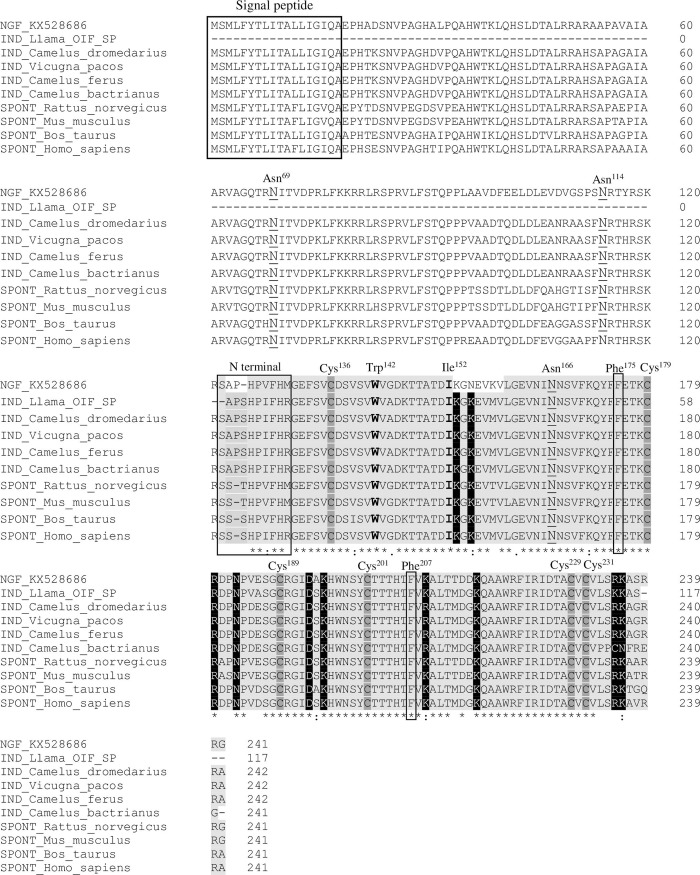
Amino acid sequence alignment of β-NGF in induced- and spontaneous ovulating species.IND (induced-ovulating species). NGF_KX528686: Oryctolagus cuniculus, KX528686; Llama_OIF_SP: ovulation inducing factor from SP of Lama lama, 4EFV_B; Camelus dromedarius, XP_010979007.1; Vicugna pacos, XP_015102944.1; Camelus bactrianus, XP_010967135.1. SPONT (spontaneous-ovulating species). Rattus norvegicus, NP_001263984.1; Mus musculus, NP_001106168.1; Bos Taurus, NP_001092832.1; Homo sapiens, NP_002497.2. The signal peptide is indicated in a box. Underlying residues (N69, N114 and N166) show glycosylation sites of Pro-NGF. The beta chain of β-NGF appears in light grey. Cysteines involved in disulfide bonds are indicated in dark gray (Cys136, Cys179, Cys189, Cys201, Cys229, Cys231). Amino acids that participate in both TrkA and p75 binding appear in bold (Trp142 and Ile152). TrkA binding sites are indicated in black boxes (N-terminal, Phe175, Phe207). P75 binding sites appear in white and highlighted in black. The differences observed in the rabbit beta chain are indicated in white.